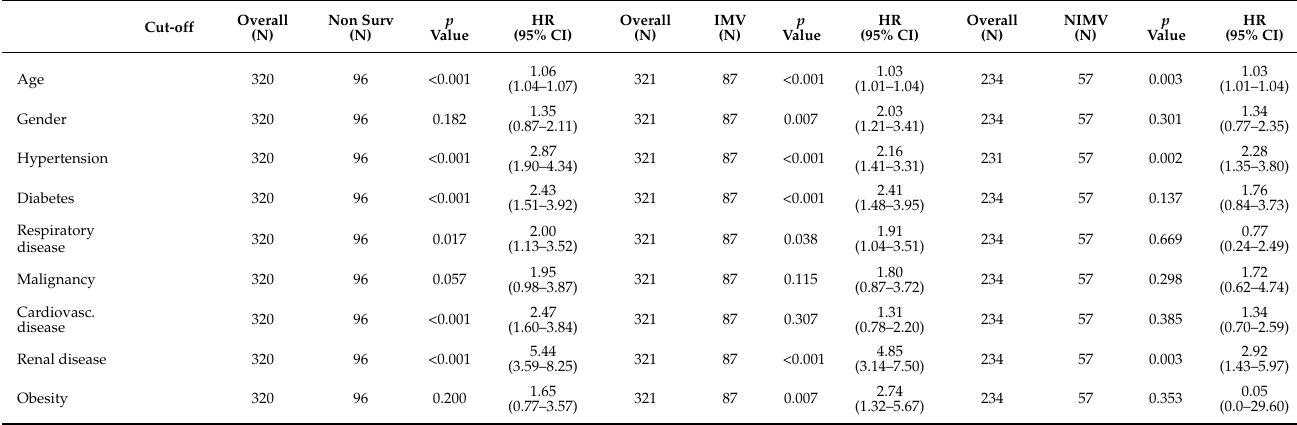
Table 3. Univariate Cox Regression Analysis for biomarkers and clinical characteristics for the primary (survivors) and the secondary (IMV, NIMV) outcomes. Univariate Cox Regression Analysis for the prediction of 45-day mortality and 28-day